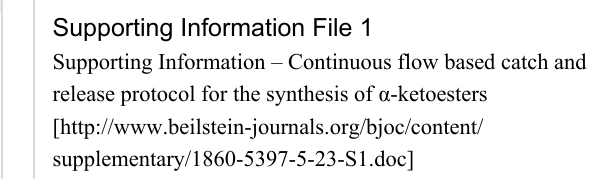
Table 1: Nitroolefinic esters 1a,c prepared under flow conditions (as described in Scheme